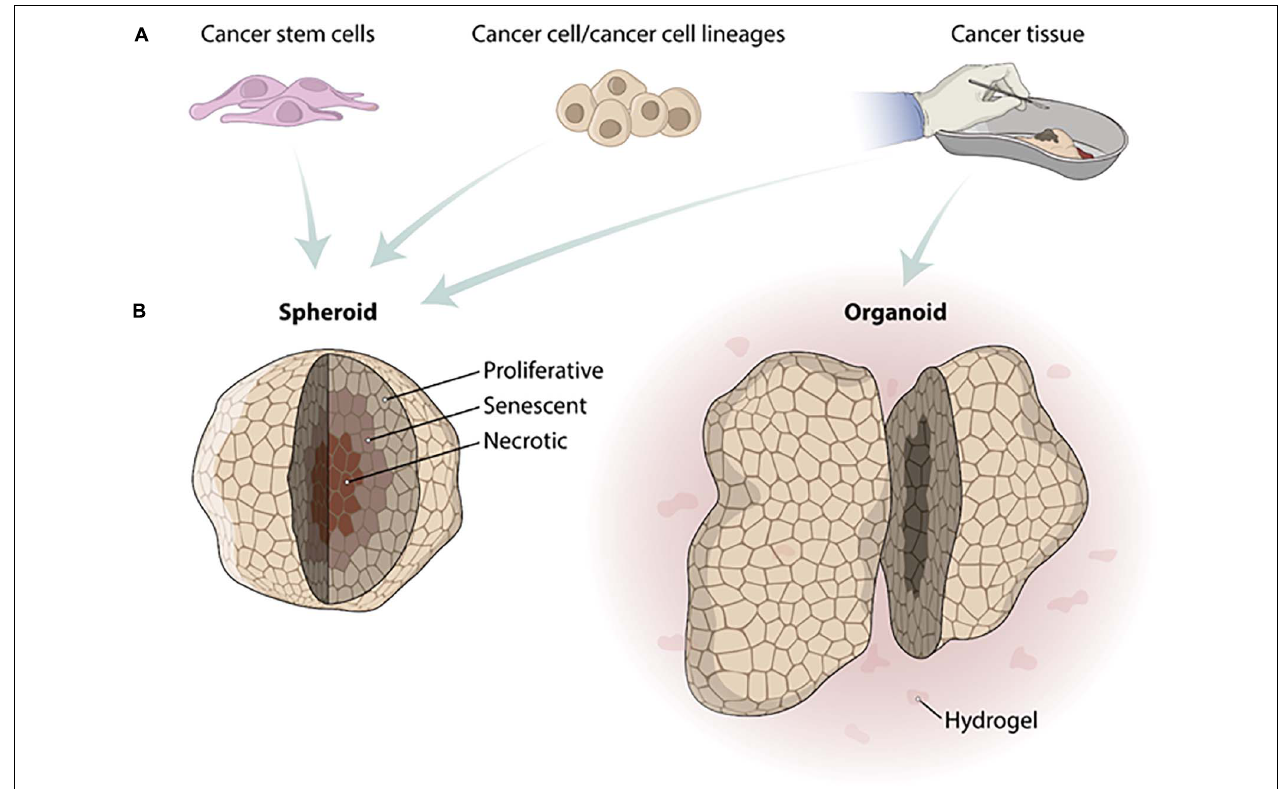
FIGURE 1 | Differences in fabrication of tumor spheroids and organoids. (A) Cell types used to produce tumor spheroids and organoids. Spheroids can be fabricated from cancer stem cells, cancer cells/cancer cell lineages, or cancer tissue. Organoids must be fabricated from human cancer biopsies. (B) After the fabrication process, tumor spheroids show different zones because of the distinct gradient concentrations of O 2 and CO 2 . The zones from spheroids inside out are necrotic, senescent, and proliferative. Organoids are usually produced in a hydrogel substrate and do not present a homogeneous size and